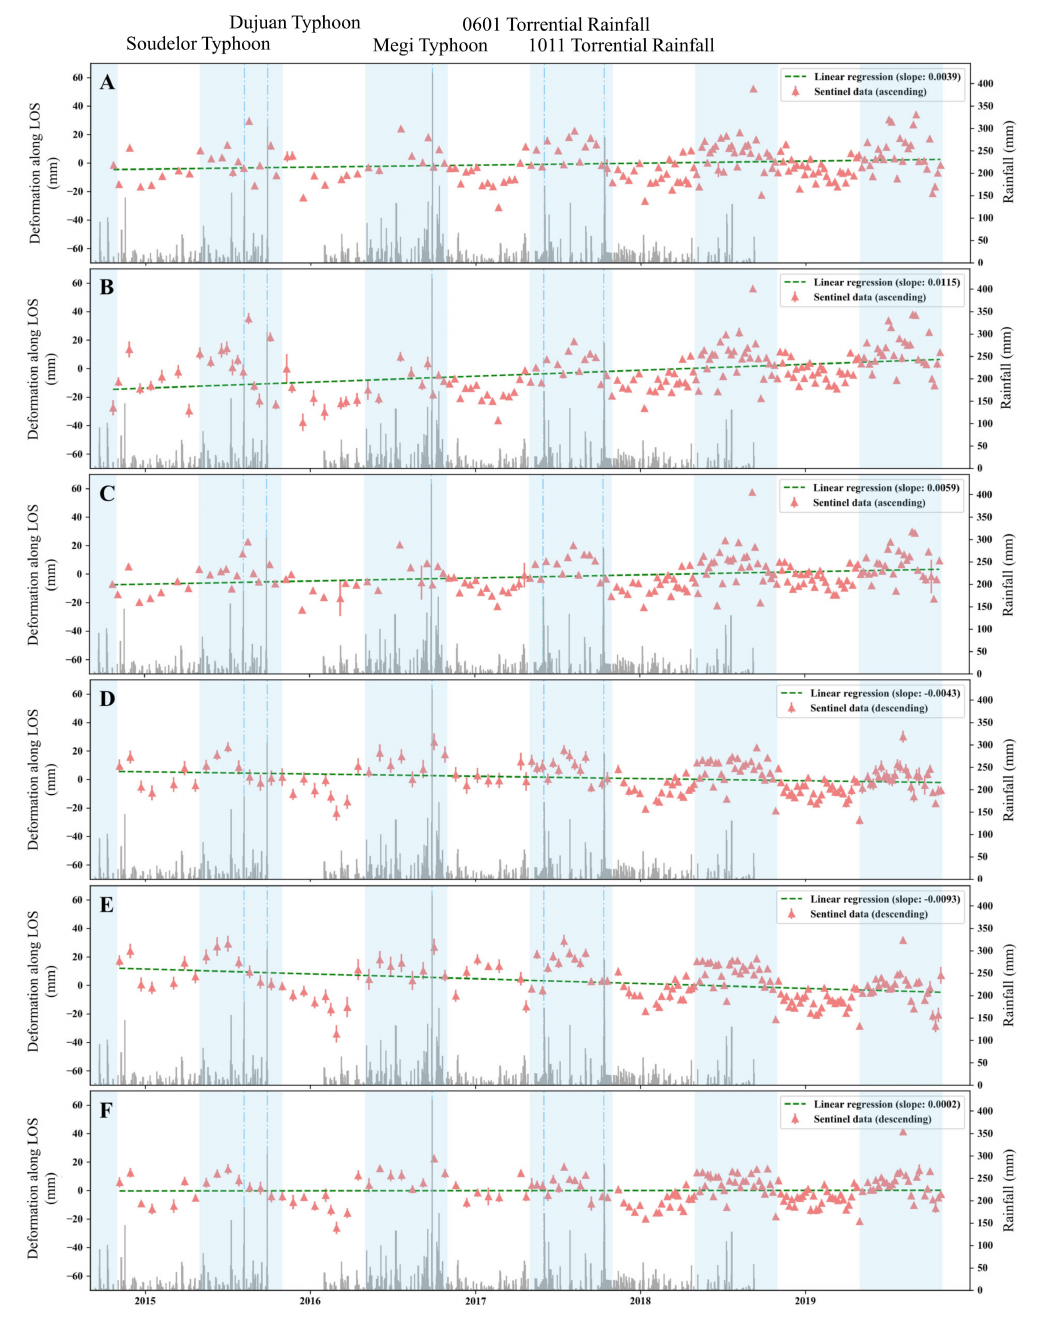
Figure 4. Time series are calculated from the average of the PS pixels within a 50 m radius of the selected PS pixel based on the ascending images and descending images from 2014-2019. The distribution of the selected PS pixels is shown in Figure 3. The time series of PS pixels A, B and C were derived from the results based on the ascending images. These time series show positive slopes, which indicate the displacements are toward the satellite along the LOS direction. The time series of PS pixels D, E and F were derived from the results based on the descending images. The negative slopes indicate the displacements are away from the satellite along the LOS direction. These time series show evident signals of long period surface displacement and clear short period surface variation. The total displacement amount was approximately 20–30 mm along the LOS direction. The orange triangles indicate the average of the selected PS pixels with an error bar of one standard deviation. The light blue background indicates the wet season periods, while the white background indicates the dry season periods. Precipitation data from 01 September 2014 to 11 September 2018 were derived from the rainfall station on the Huafan University campus, and a precipitation measurement gap existed from 10/2015 to